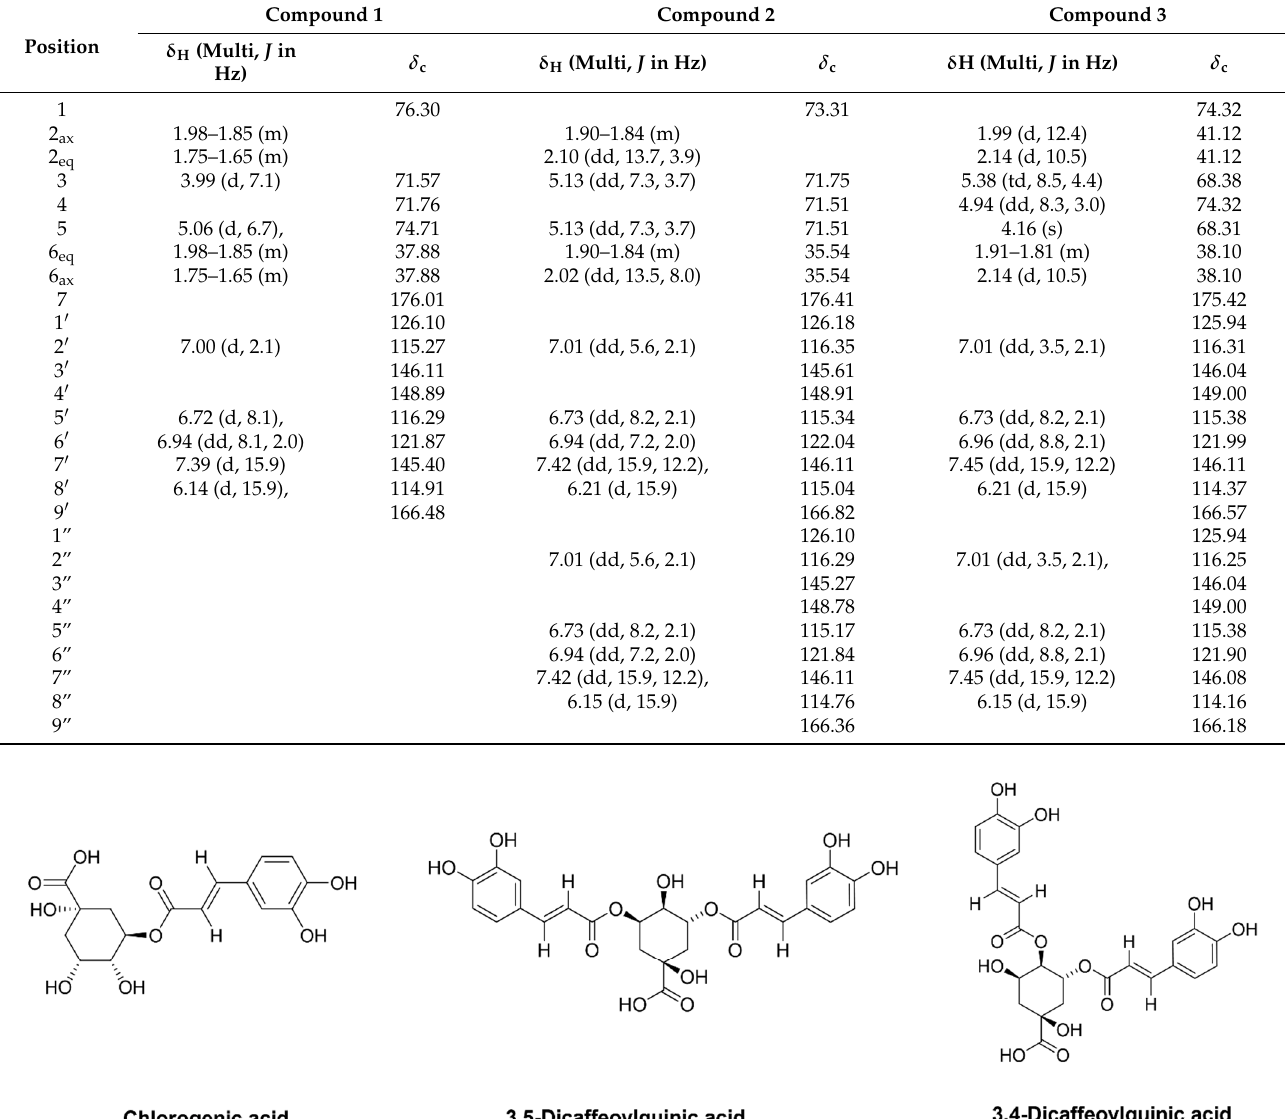
Table 1. 1 H and 13 C NMR data (in DMSO- d 6 ) of three major isolated compounds from NPR extract.